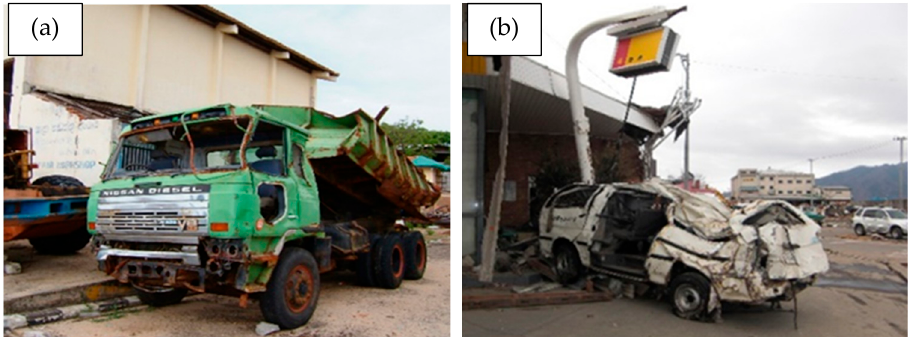
Figure 2. Damage from shipping containers: ( a ) a container collided against a house near the coast at Hitachi in Japan, and ( b ) a container broke the wall of a large warehouse at the Soma port in Japan. (3) Cars